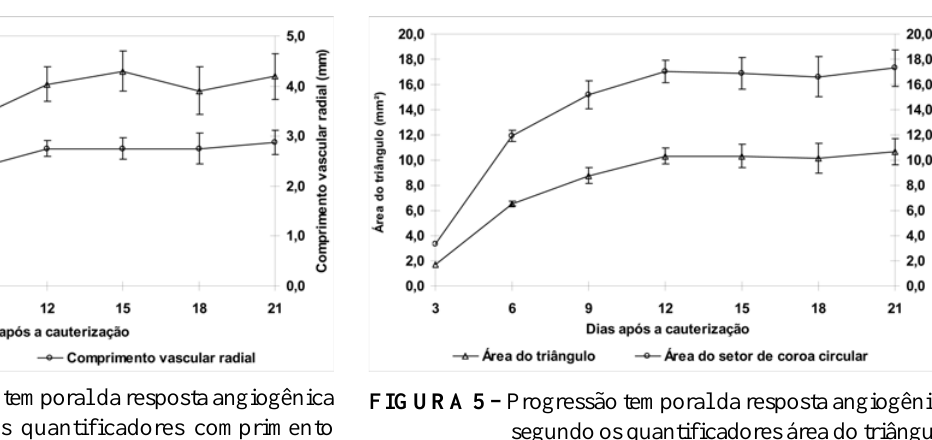
FIGURA 4 – Progressão temporal da resposta angiogênica segundo os quantificadores comprimento vascular radial e índice angiogênico. Valores expressos como média ± erro padrão da média